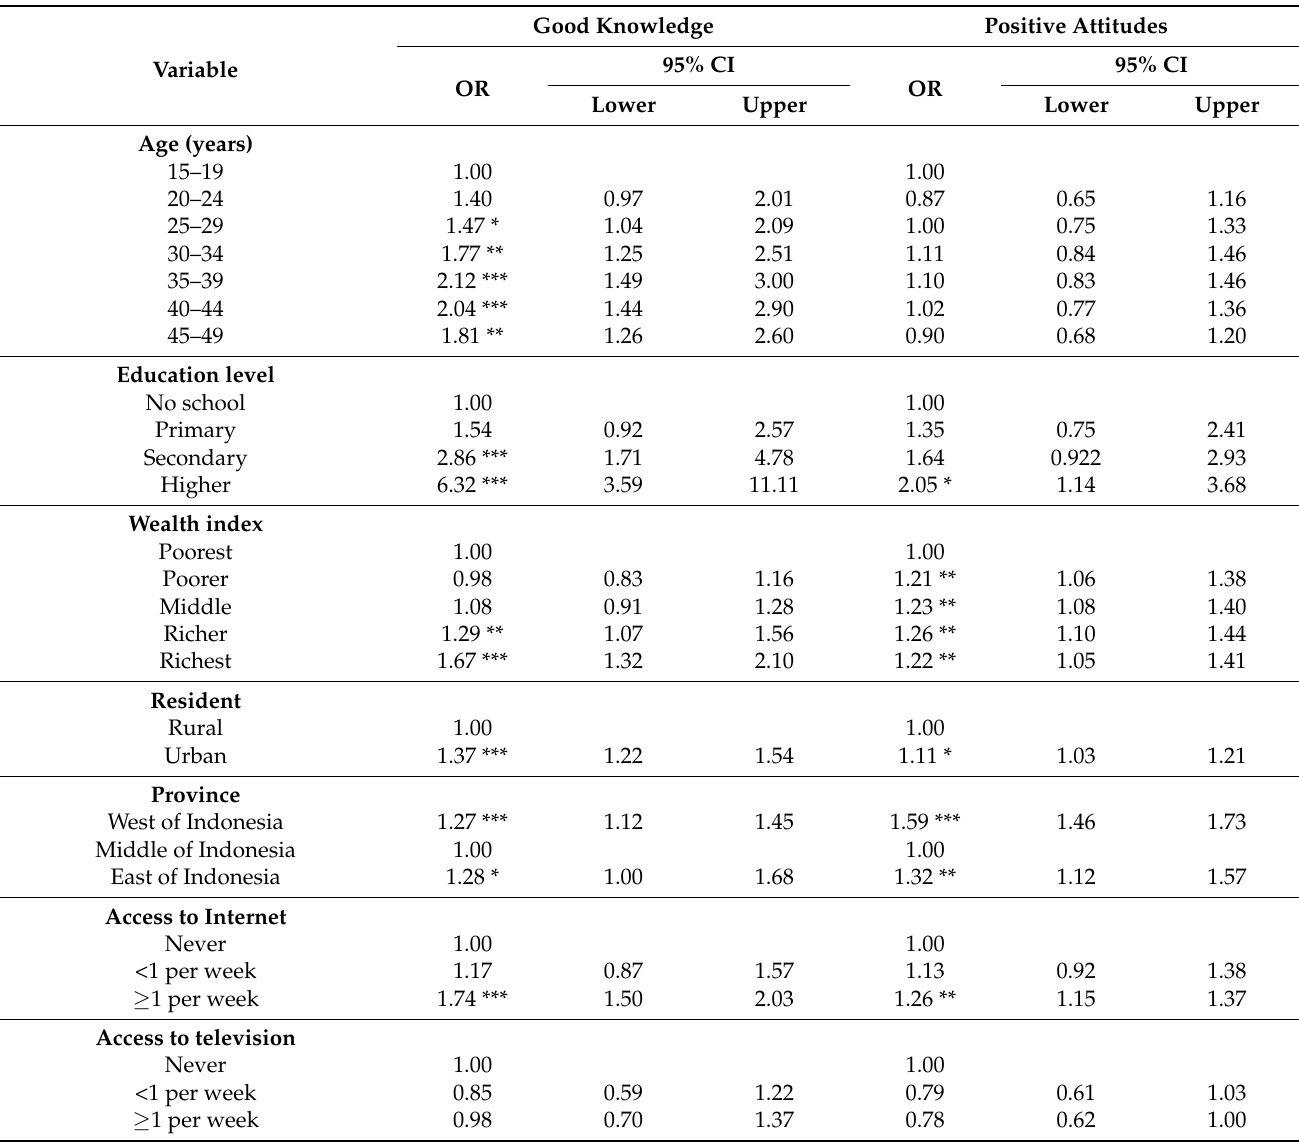
Table 4. Multiple logistic regression analysis of socioeconomic and demographic and knowledge- attitudes toward HIV/AIDS among women aged 15–49 years old in